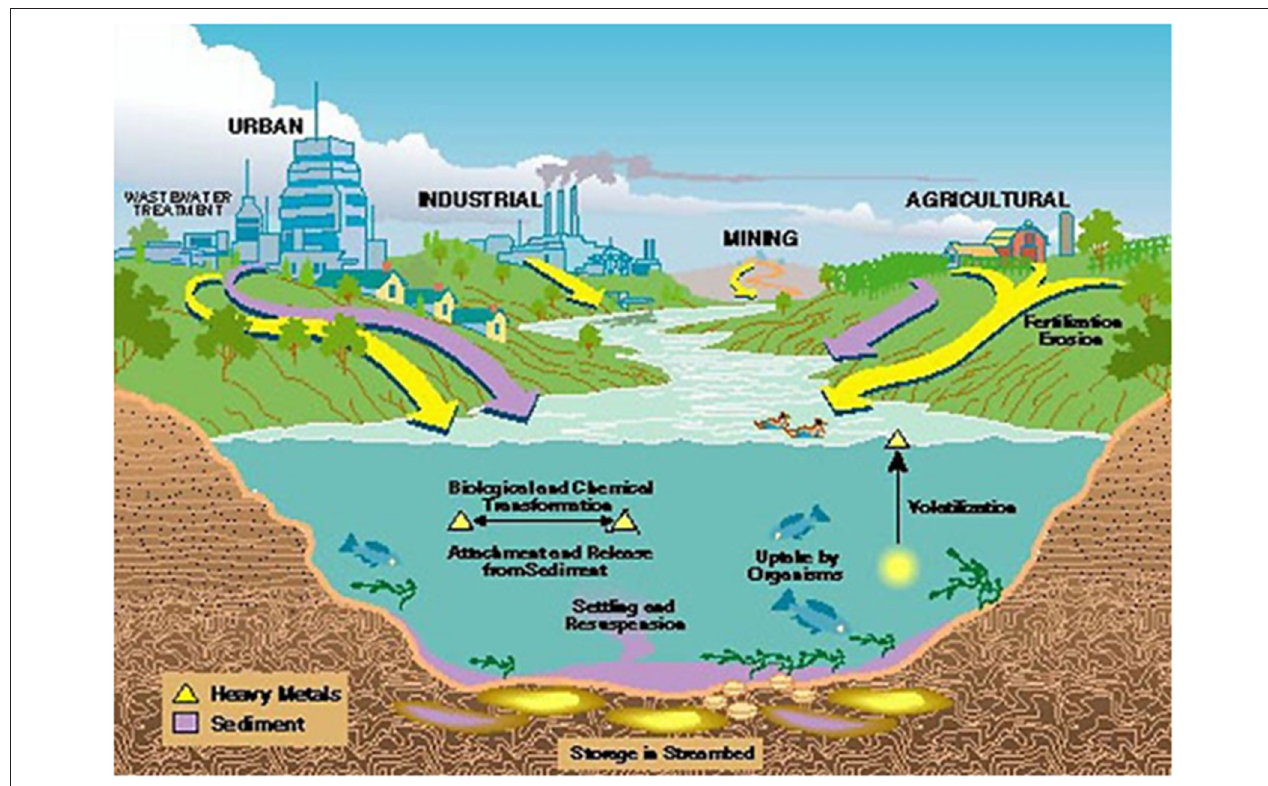
FIGURE 1 | Potential sources of heavy metals in the environment (Source: Garbarino et al., 1995).